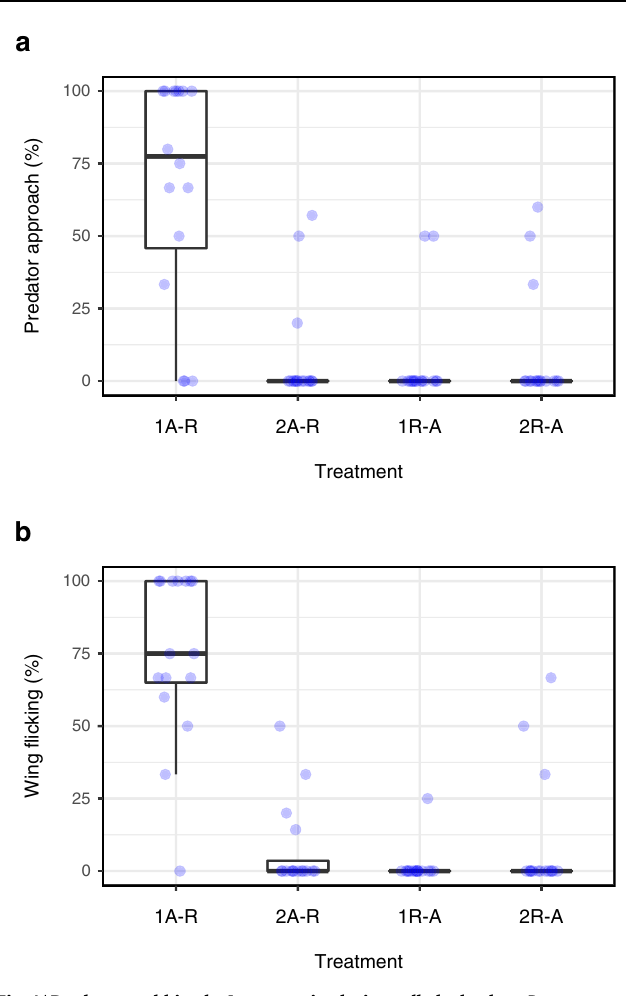
Fig.4|PredatormobbingbyJapanesetitsduringcallplaybacks.a Percentageof individualsinJapanesetit fl